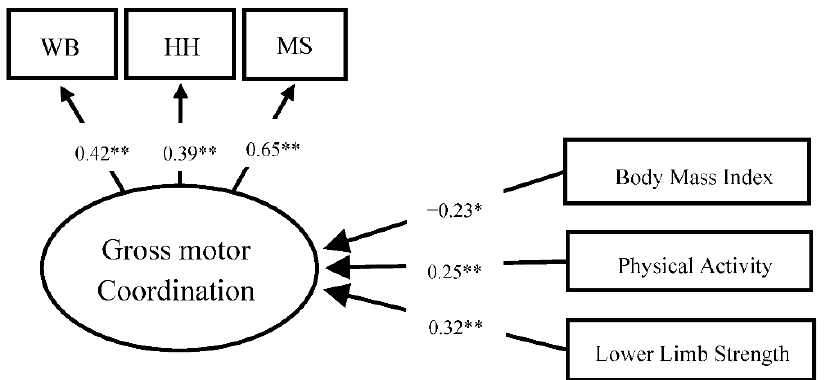
Figure 2. Children with TD motor coordination model: BMI, PA, and lower limb strength. Note: WB: walking backward along a balance beam; JS: jumping sideways over a slat; HH: hopping for height on one foot; MS: moving sideways on boards. * Statistically significant at p < 0.05. ** statistically significant at p < 0.001.